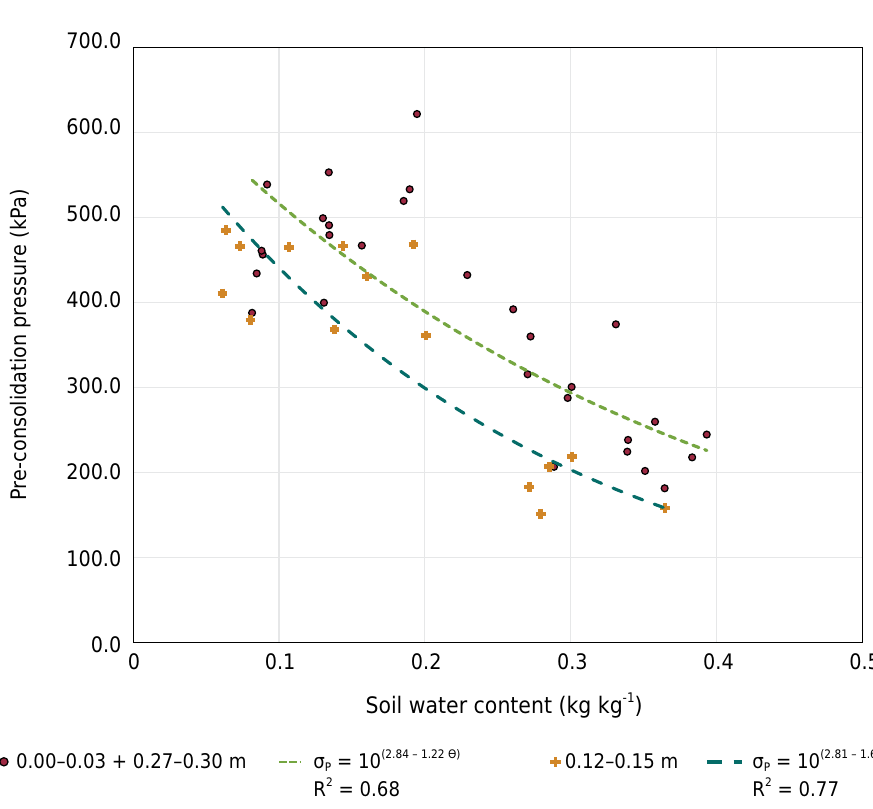
Figure 3. Load-bearing capacity model of shaded treatment after grouping data from the 0.00-0.03 and 0.27-0.30 m layers.